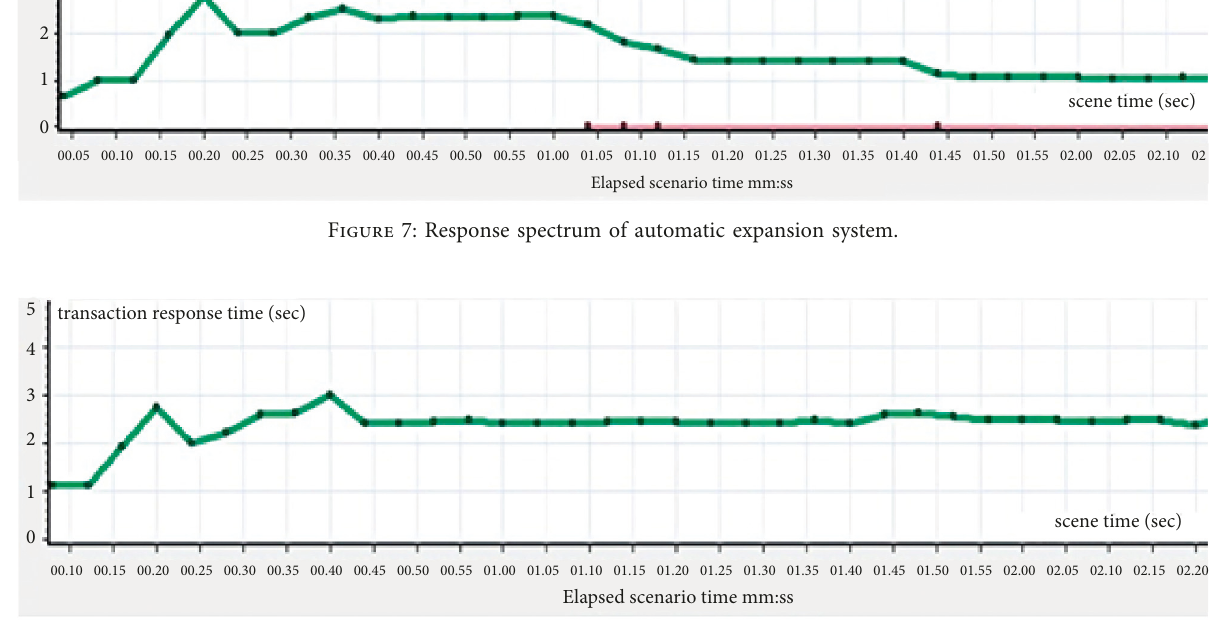
Figure 8: Response spectrum of nonexpandable